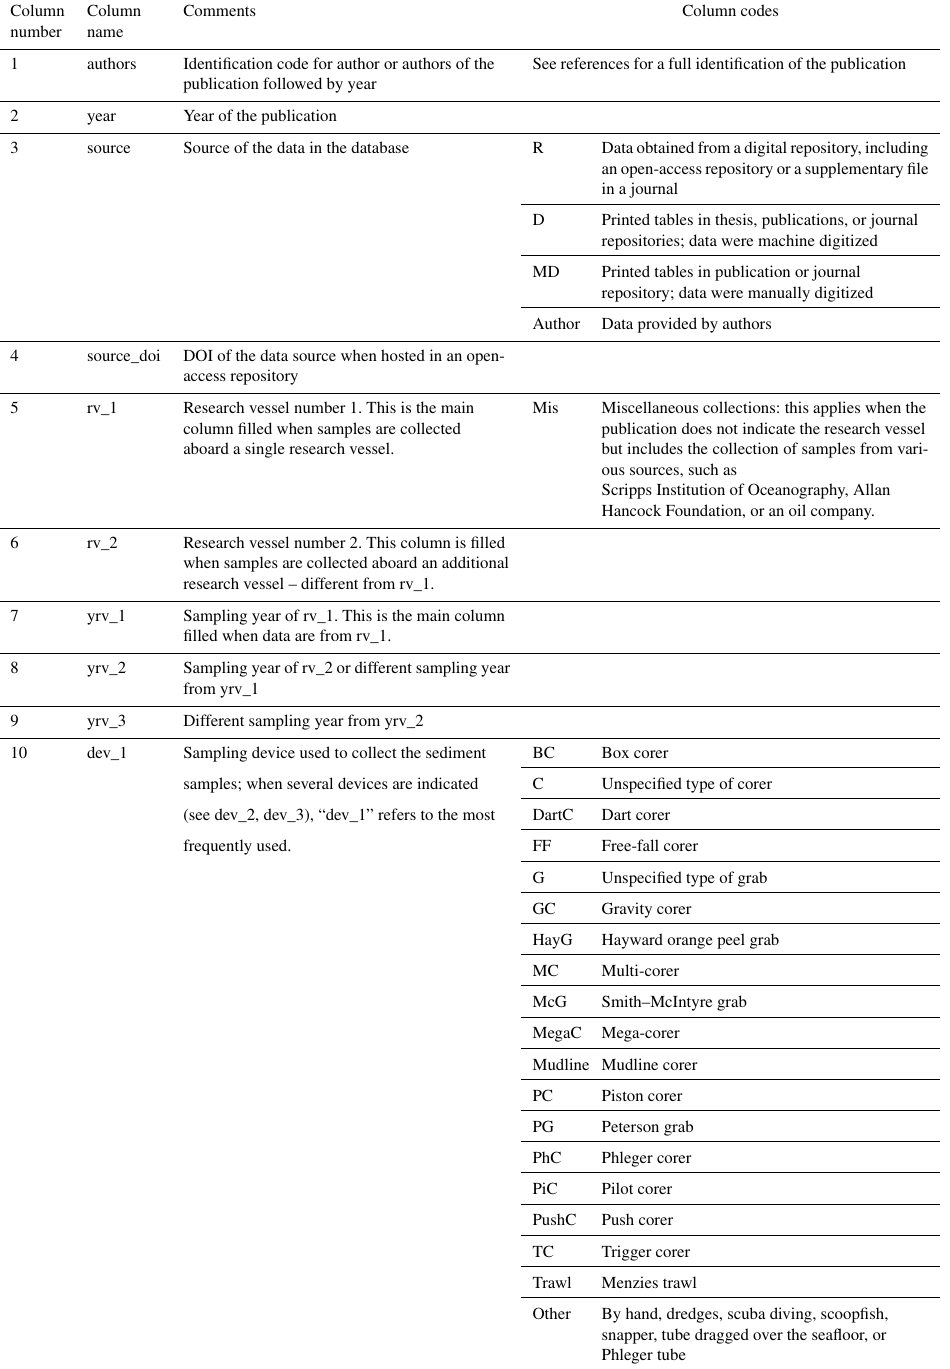
Table C1. Explanatory notes on the column names and column codes of